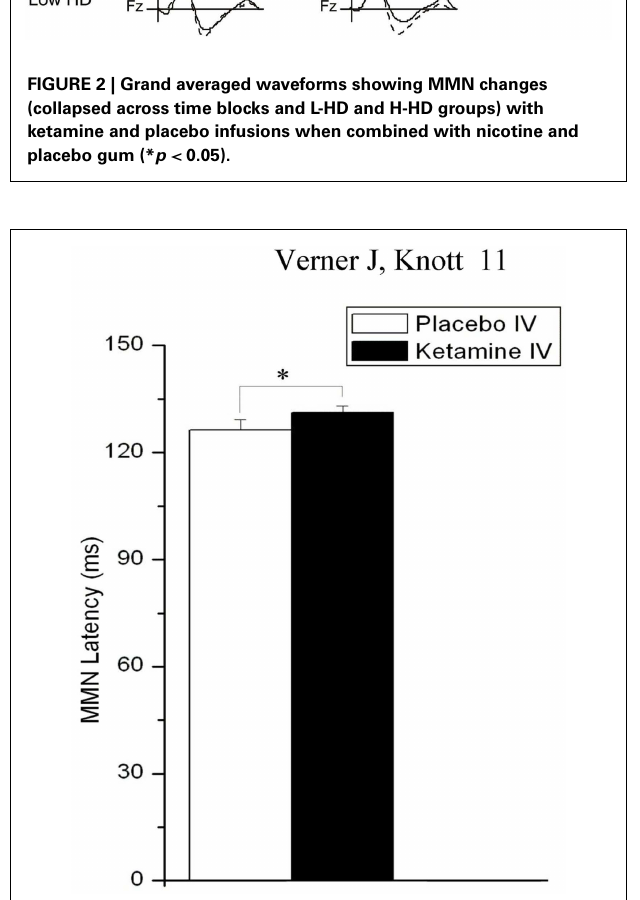
FIGURE 3 | Effects of placebo and ketamine infusion (collapsed across gum conditions, time blocks, and L-HD and H-HD groups) on mean ( ± SE) frontal (F z ) MMN latency (* p < 0.05).